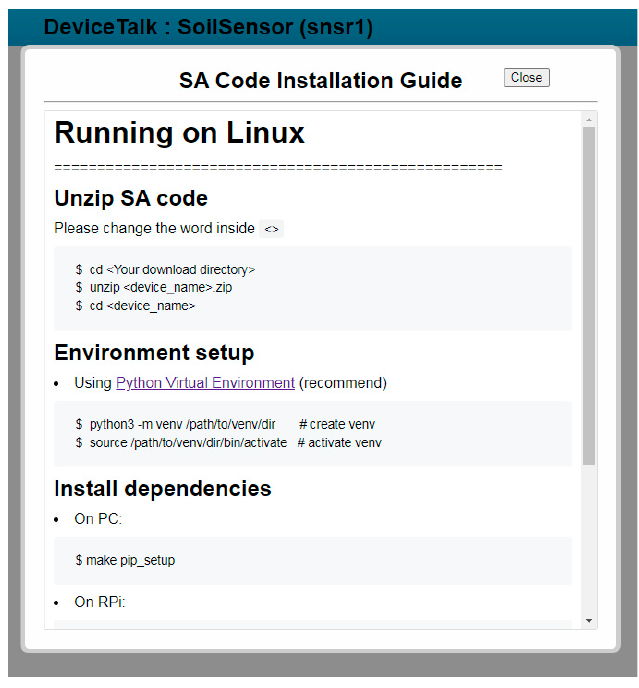
Figure 9. The SA Code Summary window.